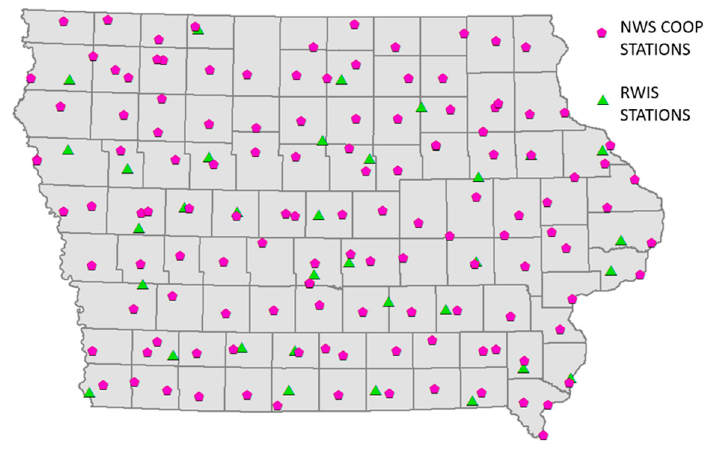
Figure 5. RWIS and NWS COOP station location map. Table 1. Summary statistics for the environmental